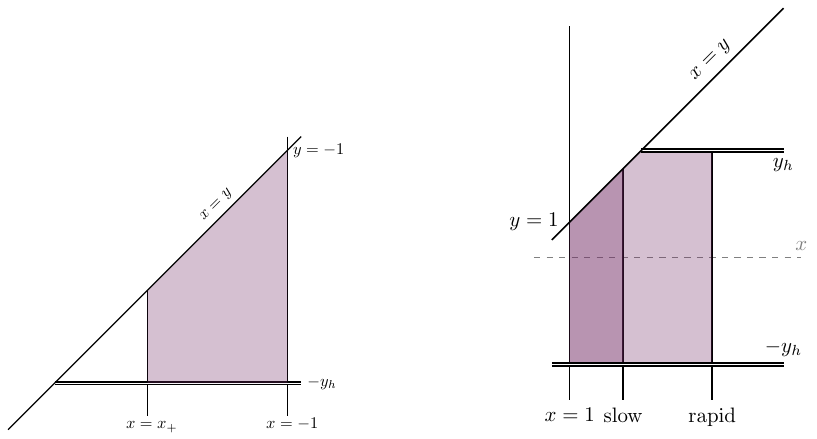
Figure 3 . Coordinate ranges for single-defect solutions constructed from metrics of Class II. Left : a wall solution for class II left , and Right : two qualitatively distinct strut solutions for class II right .